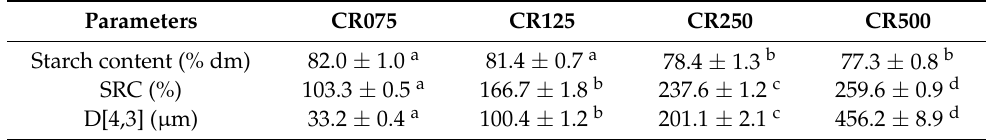
Table 1. Cassava flour